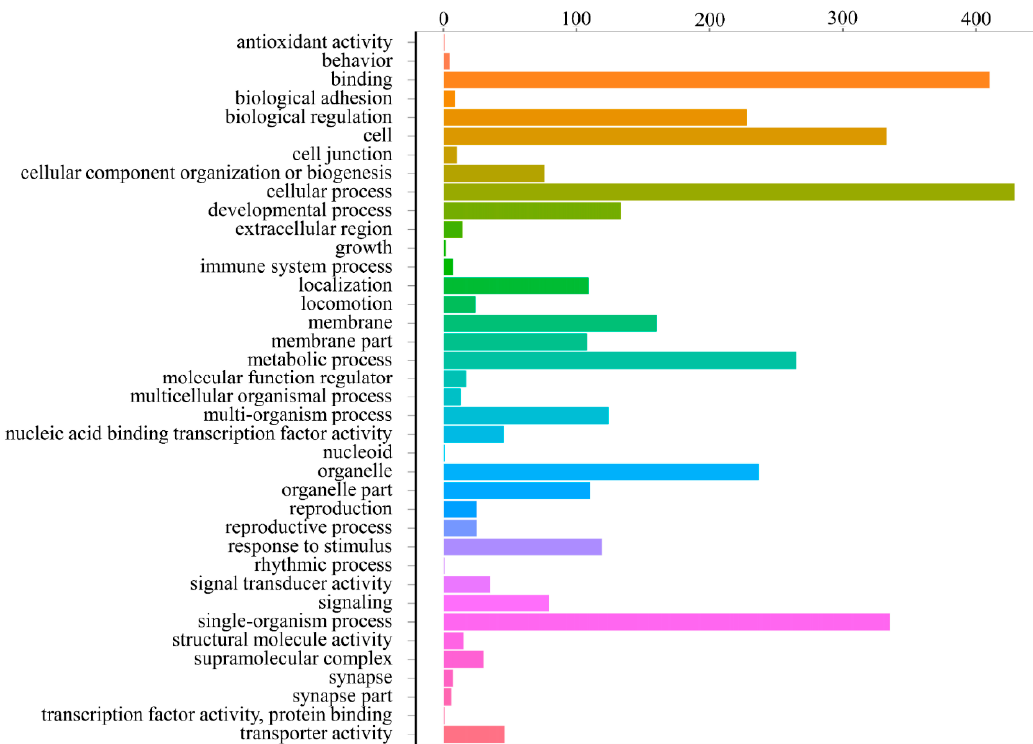
Figure 9. Gene ontology (GO) classifications of testes-biased genes. The X-axis presents the number of genes; the Y-axis presents 38 function subcategories.